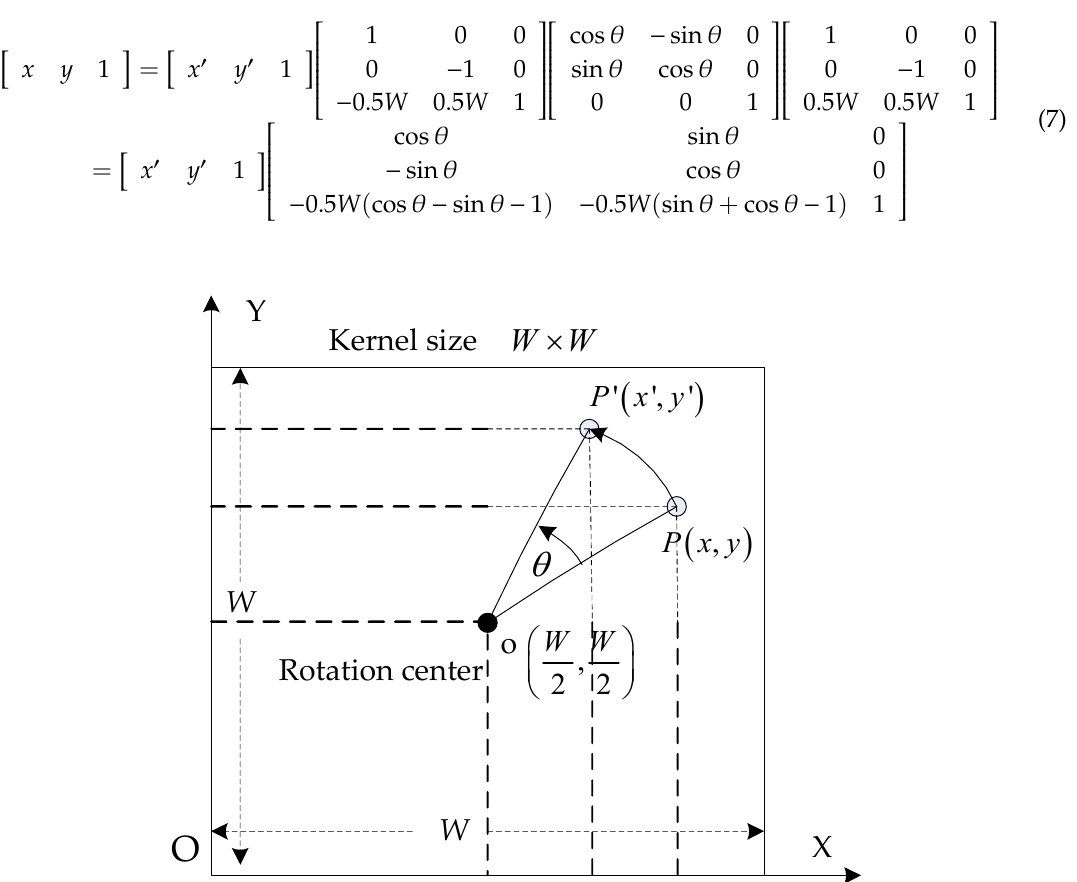
rotating the Gaussian. As shown in Figure 5, in the Cartesian coordinate system X-O-Y, point P ( x , y ) ) an angle θ to P (cid:48) ( x (cid:48) , y (cid:48) ) , which can be formulated as rotates around the point o ( W , W 2 2